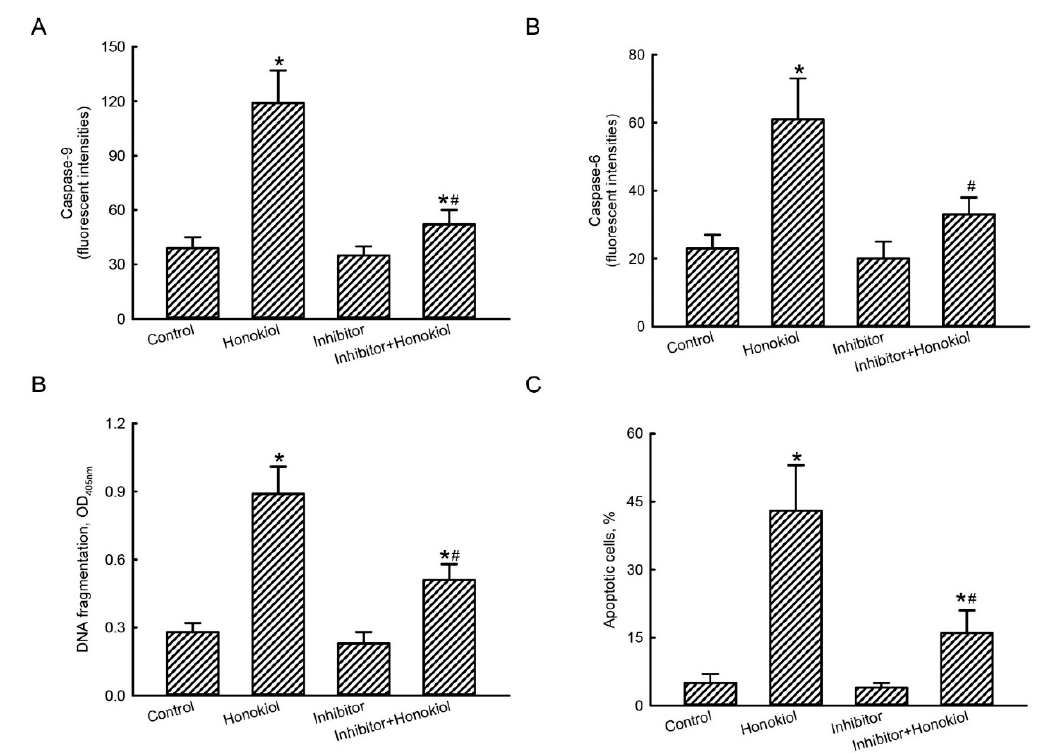
Figure 6. Involvement of caspase-9 in honokiol-induced apoptotic insults to human drug-resistant glioblastoma cells. Human TMZ-resistant U87-MG-R9 glioblastoma cells were pretreated with inhibitors of caspase-9 for 1 h and then exposed to 40 µ M honokiol for 72 h. Activities of caspase-9 ( A ) and caspase-6 ( B ) were assayed using fluorogenic substrate methods. DNA fragmentation was quantified with an ELISA kit ( C ). Apoptotic cells were measured using flow cytometry ( D ). Each value represents the mean ± SD for at least three independent determinations. The symbol * and # indicate that the value significantly ( p < 0.05) differs from control and honokiol-treated groups, respectively.